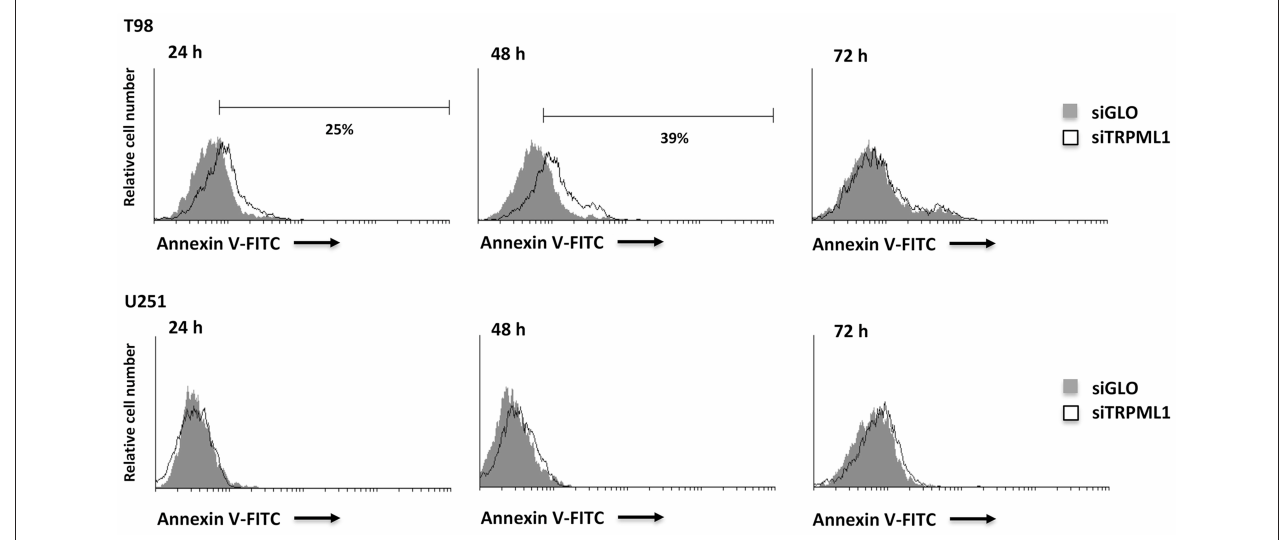
FIGURE 4 | Silencing of transient receptor potential mucolipin 1 (TRPML1) induces apoptotic cell death in T98 cells. Annexin V staining was analyzed by flow cytometry in siGLO and siTRPML1 T98 and U251 cells for up to 72h of silencing. Percentages represent the positive cells.